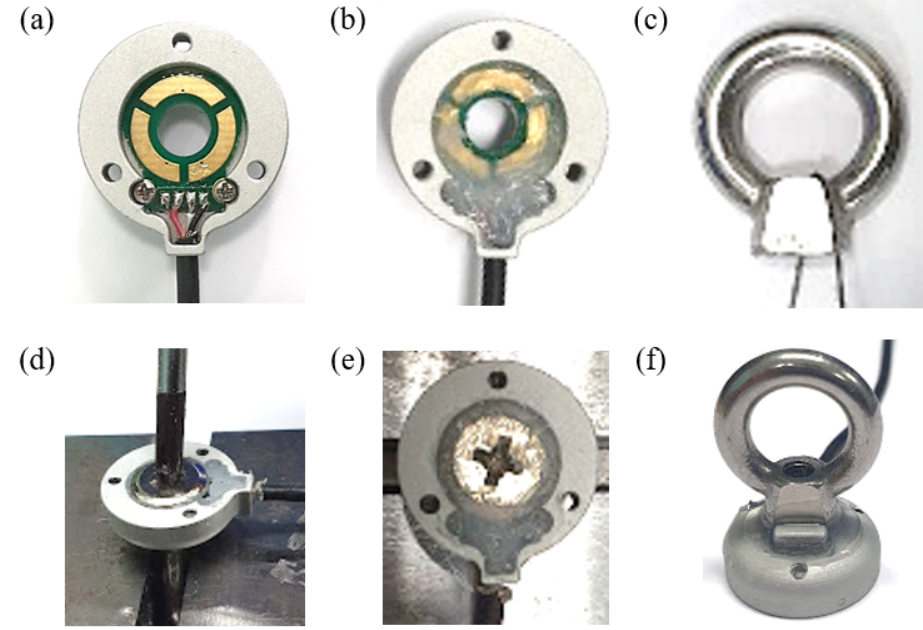
Figure 8. Fabrication process of the developed sensor. ( a ) Connect the sensing board with the base part. ( b ) Add a silicon adhesive. ( c ) Hang a conductive wire. ( d ) Tight with a bolt. ( e ) Coagulate adhesive. ( f ) Fabrication